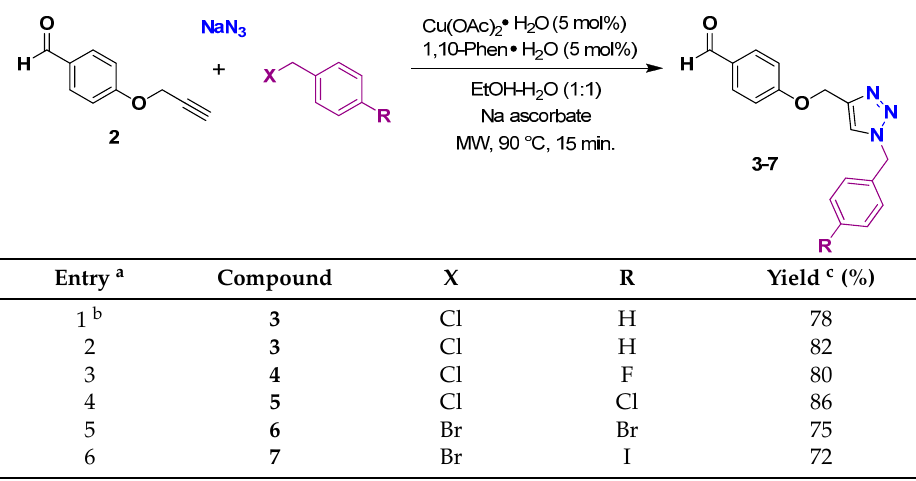
Table 1. One-pot three-component reaction catalyzed by Cu(OAc) 2 ·H 2